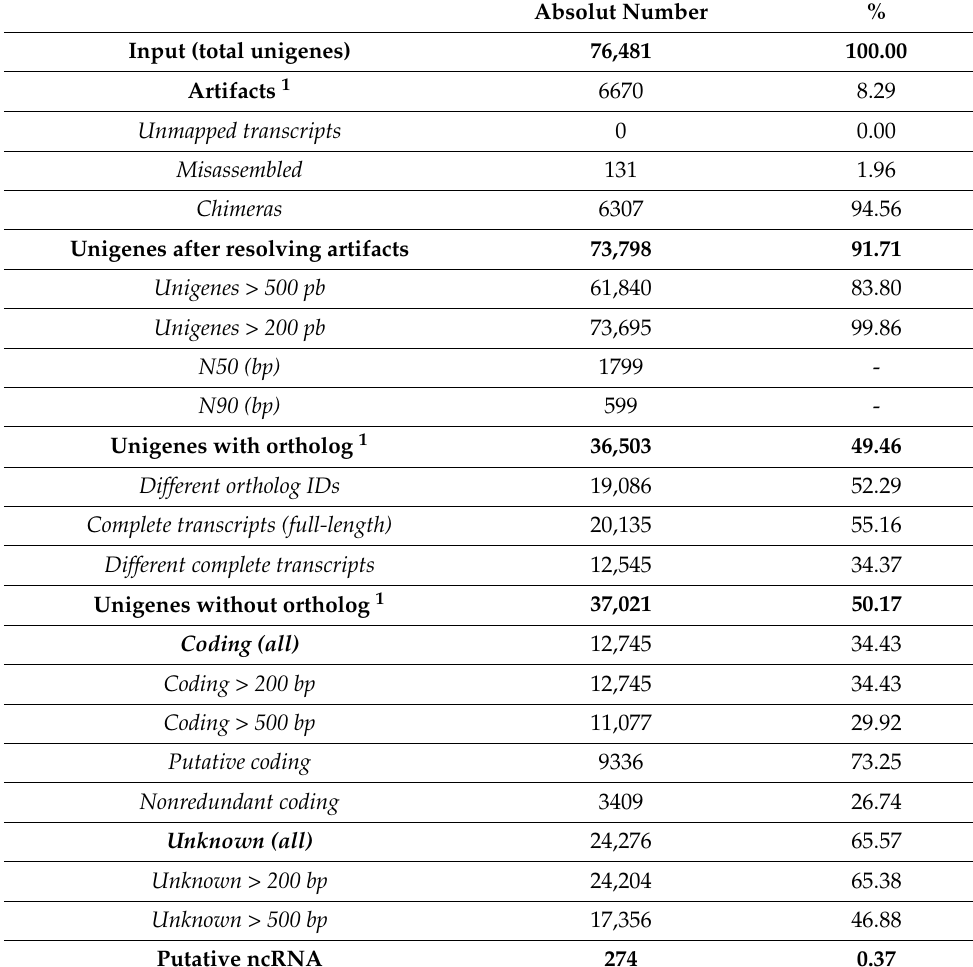
Table 2. Summary of final data for transcriptome of A. pinsapo